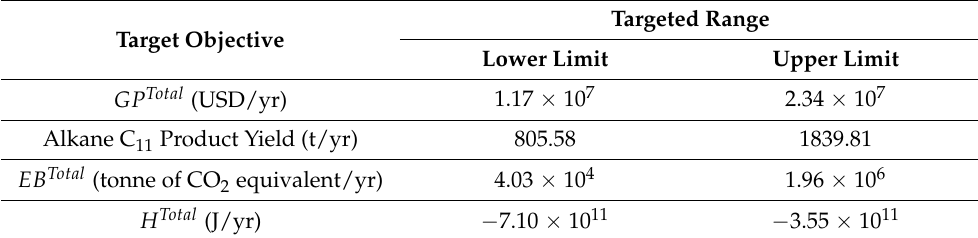
Table 9. Upper and lower